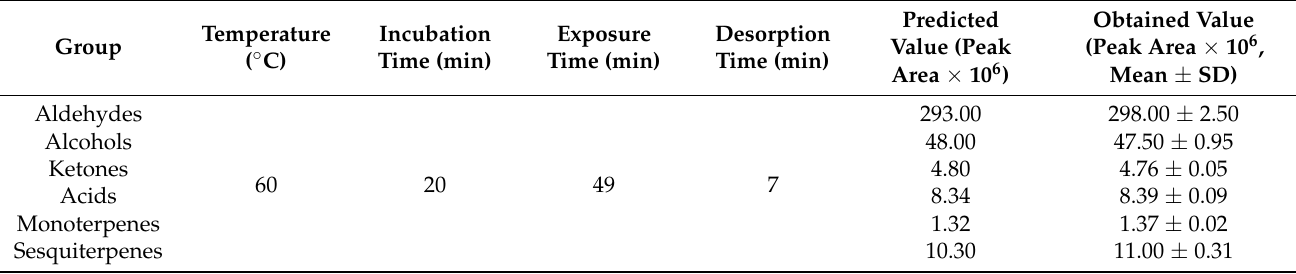
Table 2. Optimal SPME-Arrow extraction conditions, predicted and experimentally obtained values for individual groups of free volatile